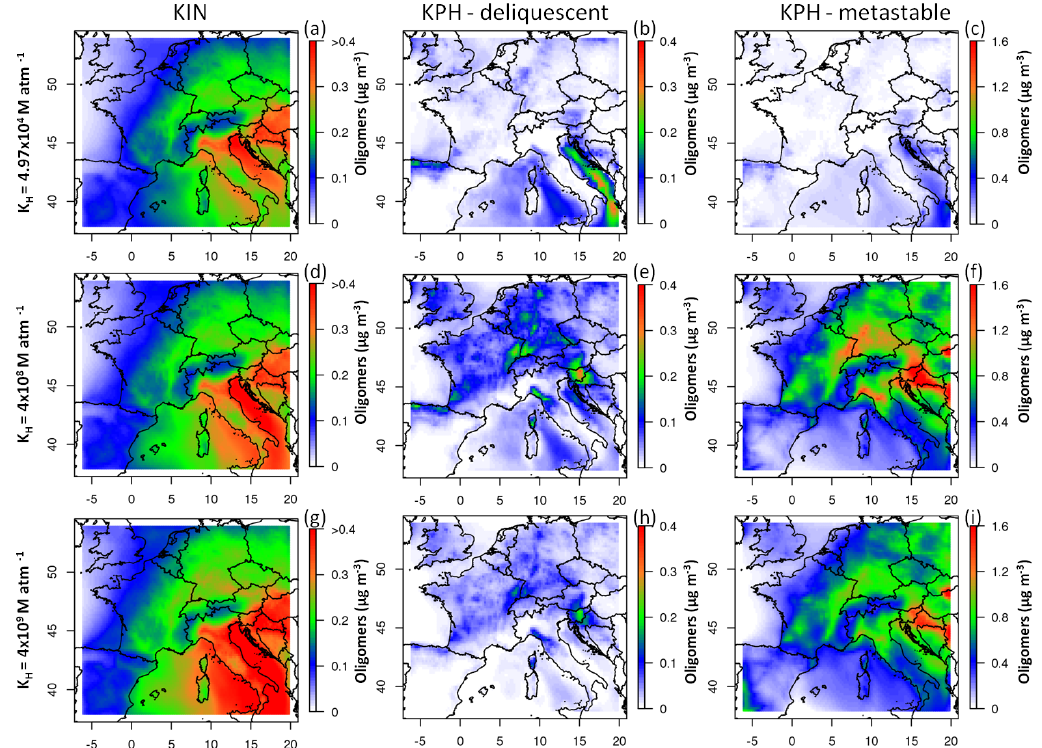
Figure 12. Mean modeled oligomer concentrations from monoterpenes hydrophilic surrogates (thus without BiBmP) for both approaches: KIN (left), KPH deliquescent (center) and KPH metastable mode (right) over 20 July–3 August 2006. The simulations are conducted using for BiA0D the following K H values: 4 . 97 × 10 4 Matm − 1 (top, a, b, c ), 4 × 10 8 Matm − 1 (middle, d, e, f ) and 4 × 10 9 Matm − 1 (bottom, g, h, i